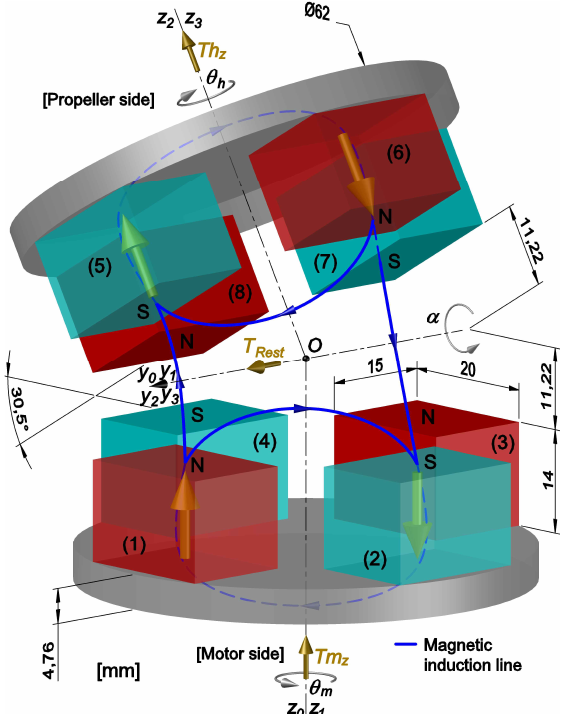
Figure 23. Flat-RMCT model. Configuration with α max , θ m = θ h = 0°